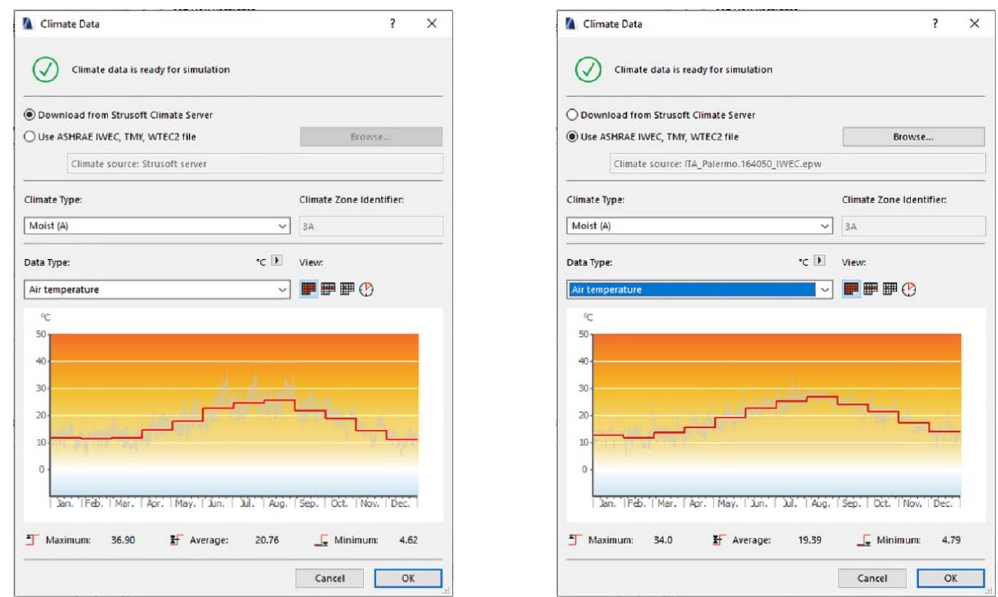
Figure 4. On the left the climatic data obtained from the Strusoft server, on the right the climatic data G. De Giorgio.